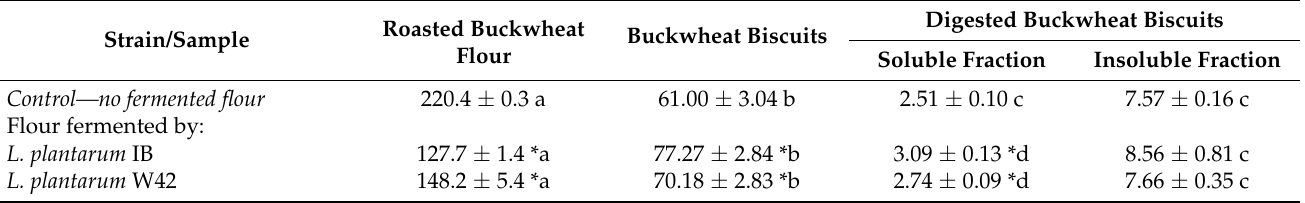
Table 2. The content of rutin (Ru) in fermented roasted buckwheat flours and buckwheat biscuits before and after digestion in vitro ( µ g g − 1